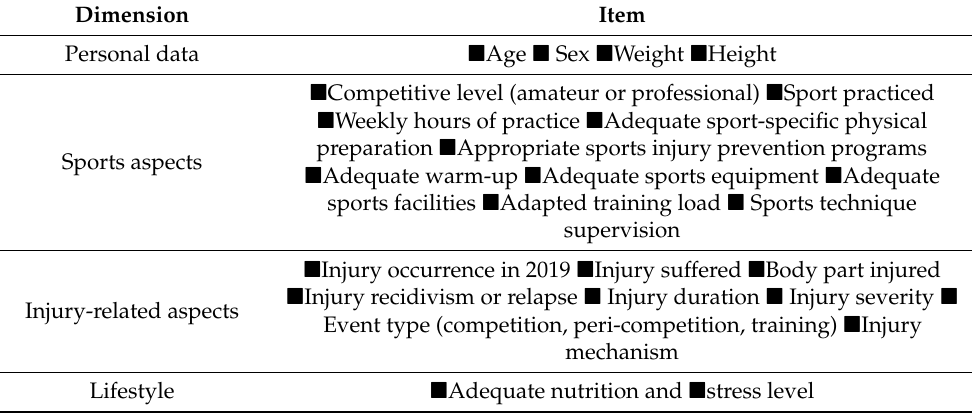
Table 1. Items included in the checklist used to collect the data. Dimension